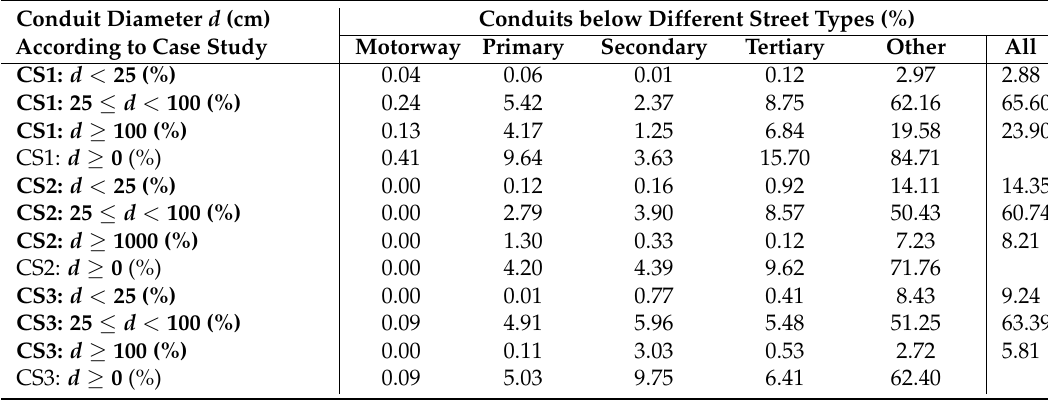
Table A2. Conduit diameter in correlation with street